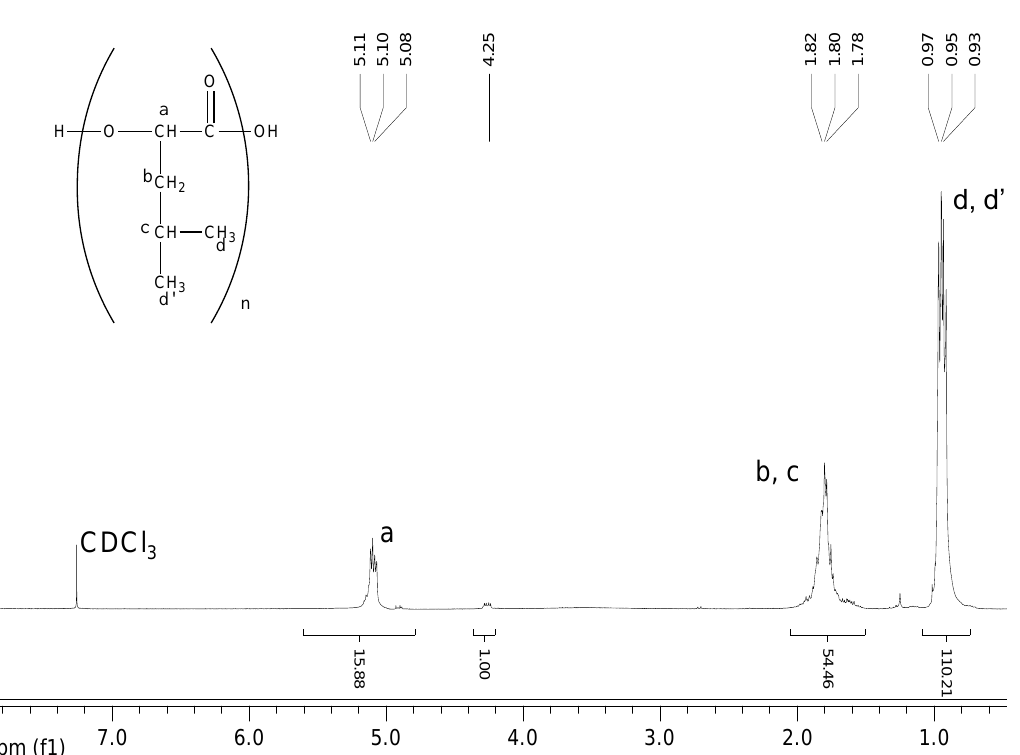
Figure 1. 1 H-NMR spectrum of PolyHOLeu.